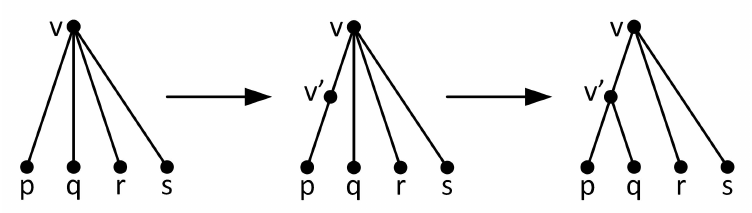
Figure 10. Rethinking a vertex